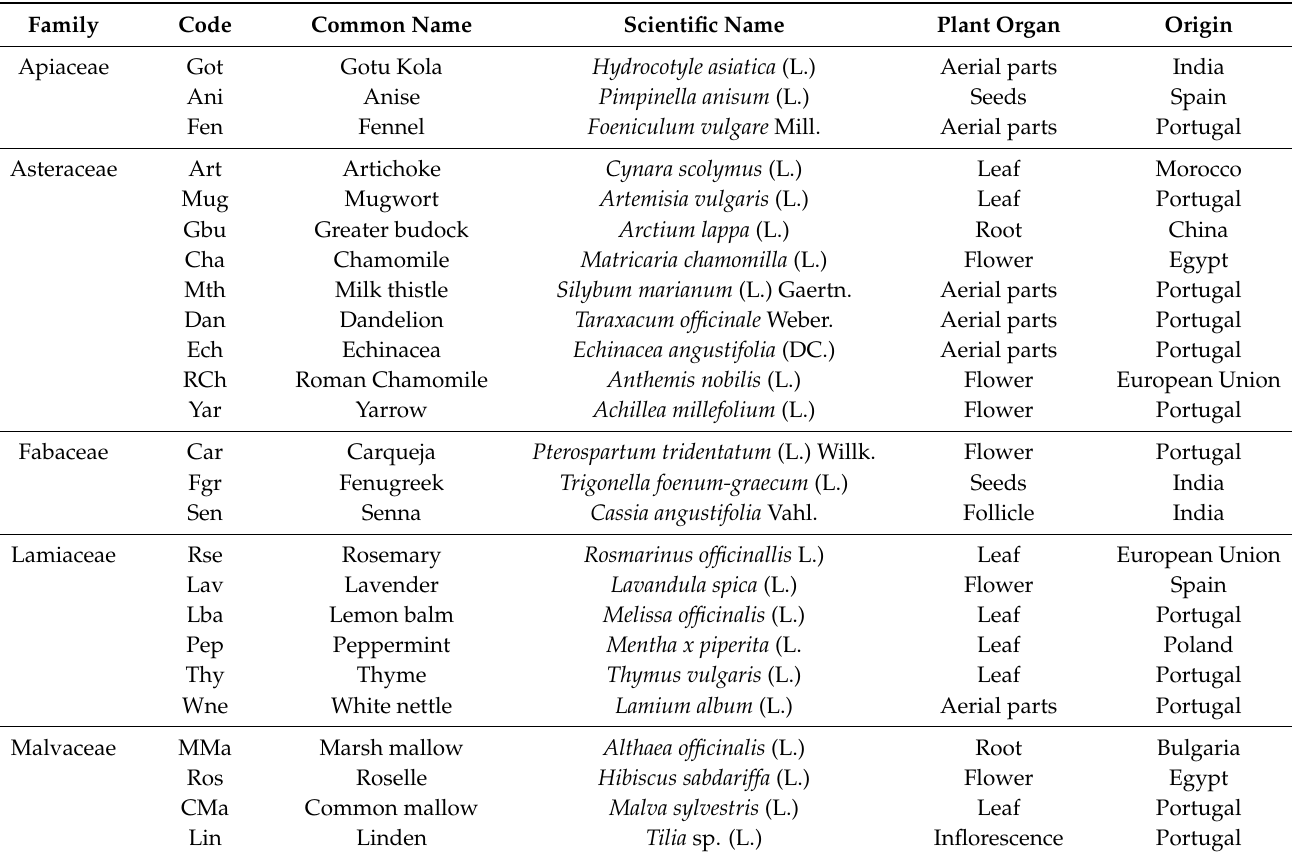
Table 1. Identification of samples.